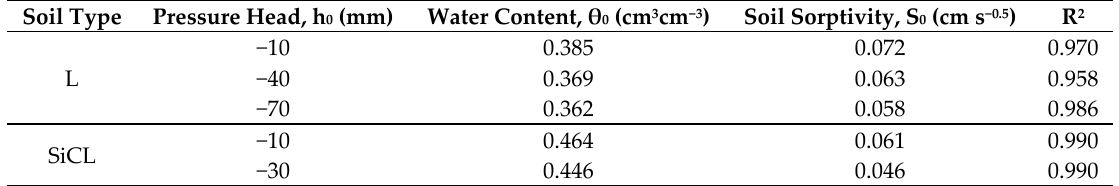
Table 2. Parameters of one-dimensional infiltration experiment for loam (L) and silty clay loam (SiCL) soil and the coefficient of determination R 2 between the experimental infiltration data fitted curve for S 0